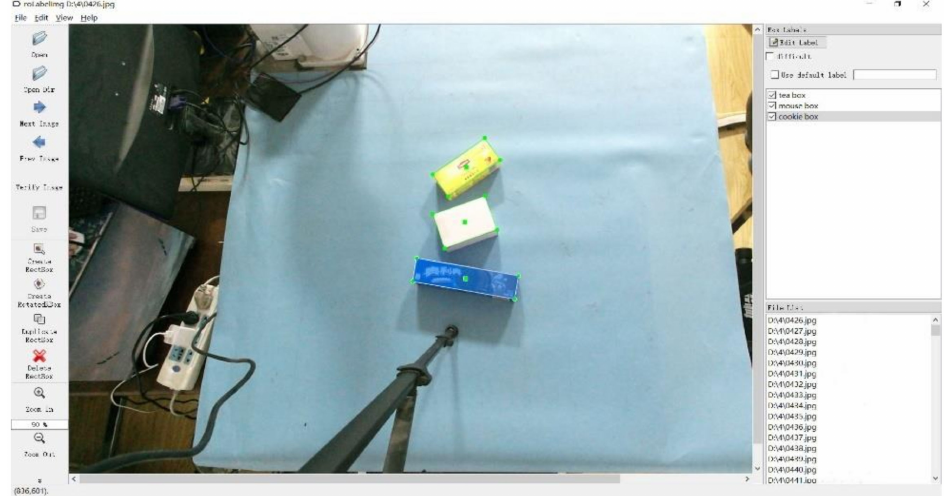
Figure 5. Labeling